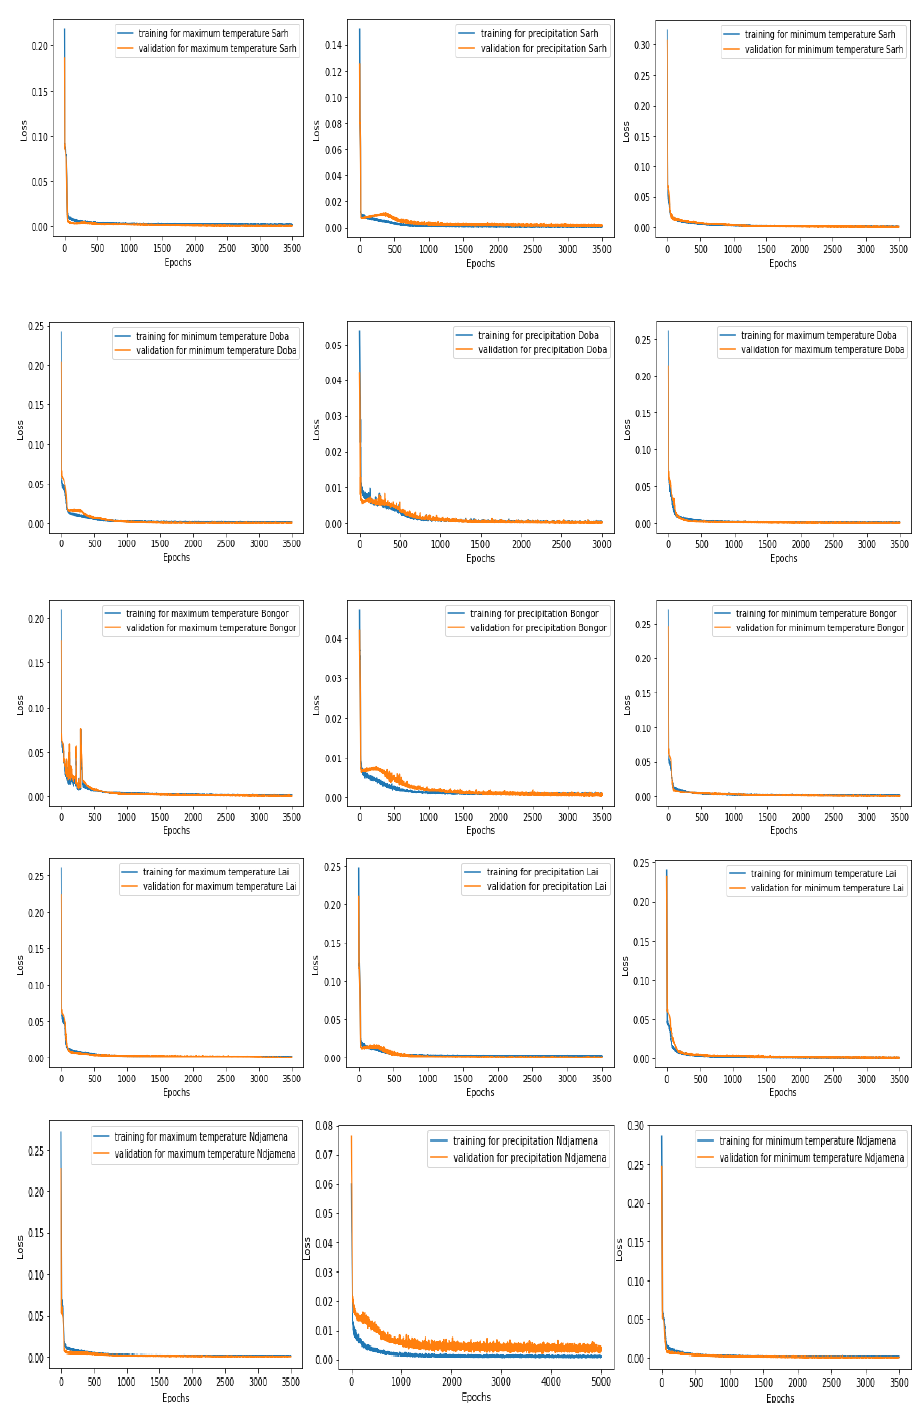
Figure 4. The training and validation loss function plots for the maximum and minimum temperature and precipitation forecasting for the five gauging